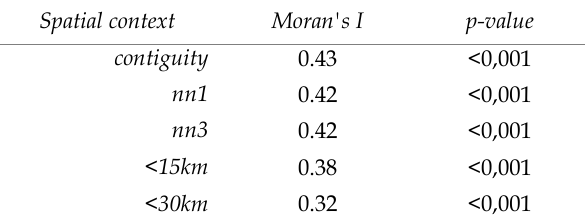
Table 3: Moran's I for different spatial contexts